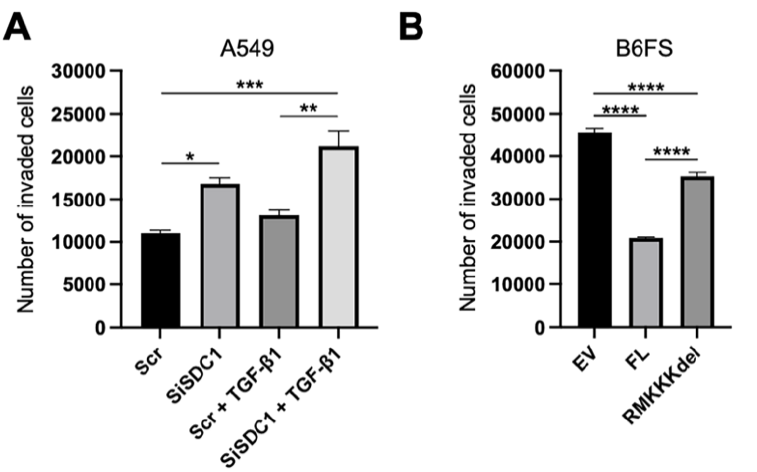
Figure 7. Impact of nuclear SDC1 on tumor cell invasion. ( A ) Bar graphs showing the impact of SDC1 knockdown +/ − TGF- β 1 treatment on the invasive capacity of A549 cells. ( B ) Bar graph showing the effect of overexpressing FL SDC1 or the RMKKKdel mutant on the capacity of B6FS cells compared to the empty vector (EV). The results represent the mean values of three independent experiments. * = p < 0.05; ** = p < 0.01; *** = p < 0.001; **** = p < 0.0001.